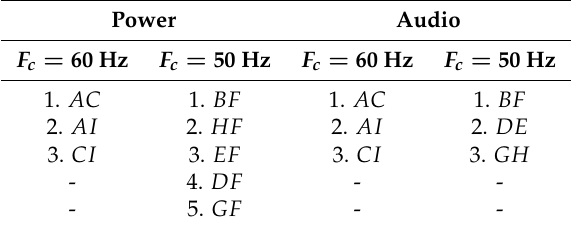
Trained support vector machine (SVM) Models for 60 Hz and 50 Hz Power and Audio Recordings.